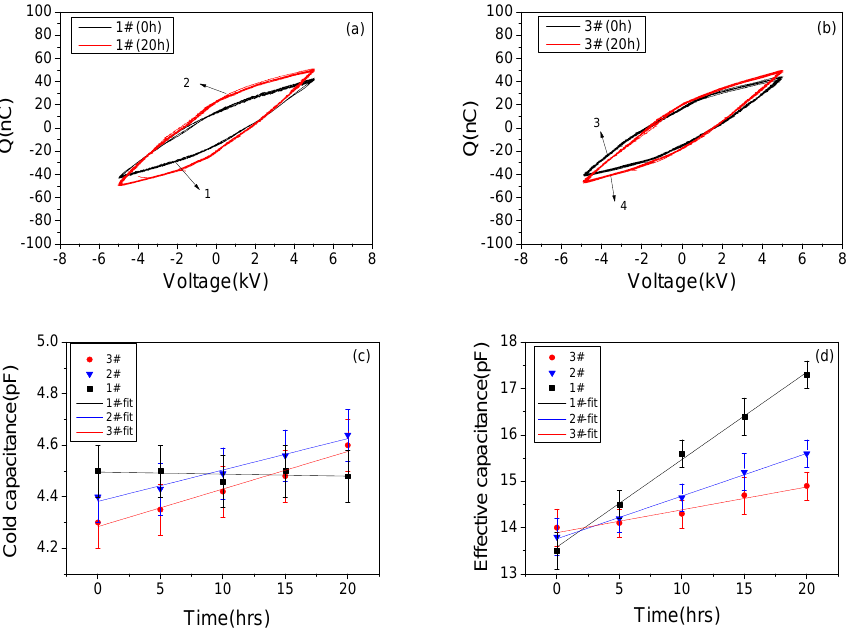
Figure 5. Lissajous figures of un ‐ fluorinated device ( a ) and 60 min fluorinated device ( b ) at the aging times of 0 and 20 h, cold capacitance ( c ) and effective capacitance ( d ) as a function of the aging time for the three devices.